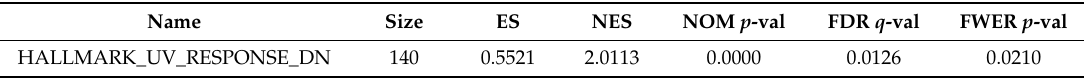
Figure 3. Gene set enrichment analysis (GSEA) demonstrated significant enrichment of the following hallmark gene sets to AR mRNA expression in ER-positive BC in TCGA. ( A ) UV response down gene set enriched in high expression of AR mRNA; ( B ) DNA repair gene set enriched in low expression of AR mRNA. Table 1. Significant gene sets that associated with high expression of AR using Gene Set Enrichment Analysis (GSEA)(TCGA).